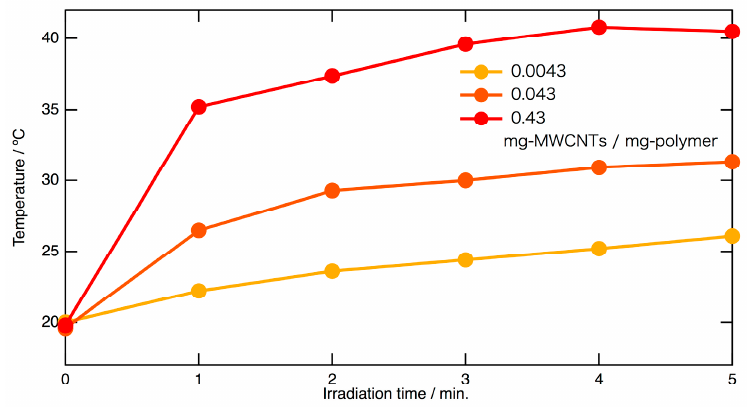
Figure 5. Temperature change observed for polyvinyl 4-(chloromethyl)benzoate/MWCNT with different MWCNT amounts.